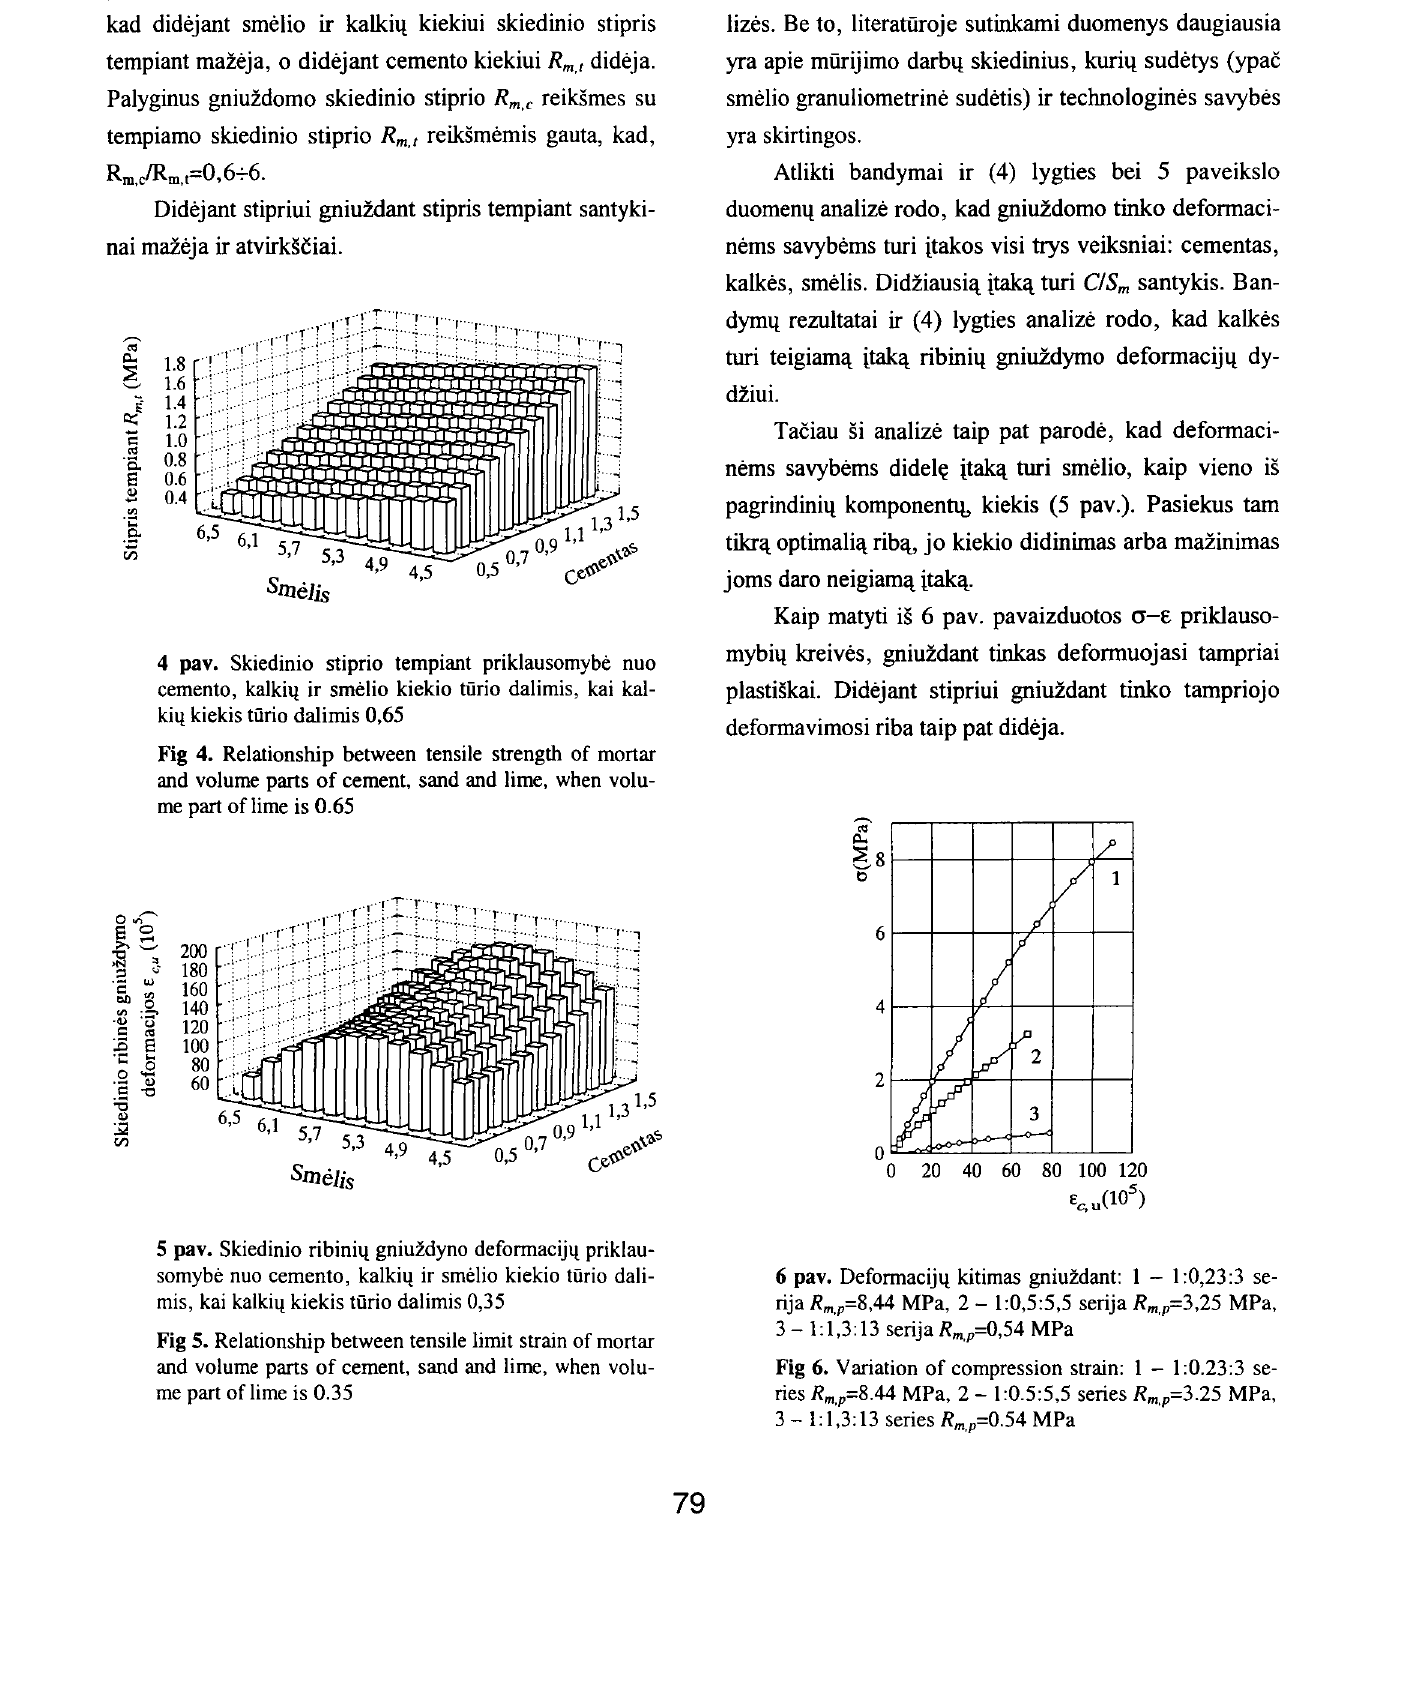
Fig 6. Variation of compression strain: 1 - 1:0.23:3